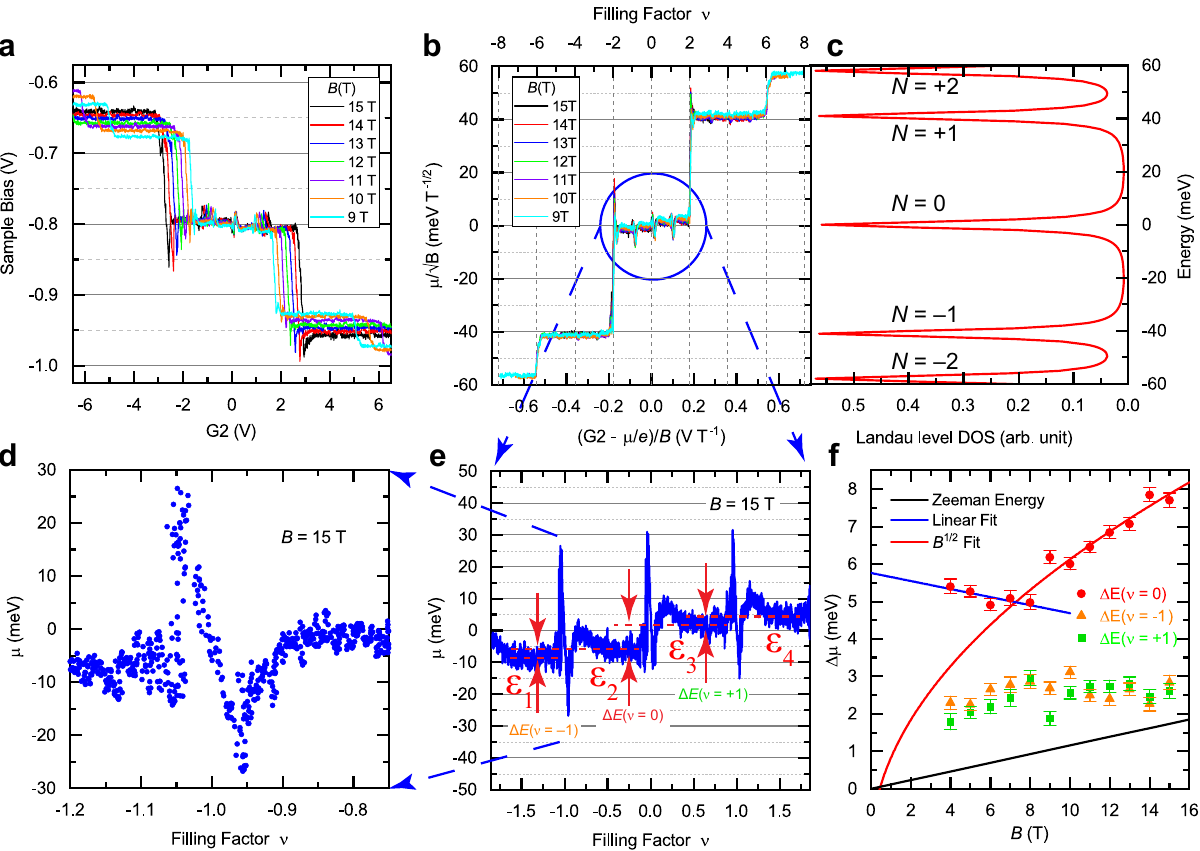
Fig. 3 Resolving the energies of the four isospin components of the graphene zero Landau level with Kelvin probe spectroscopy. a Kelvin probe measurements varying the sample bias and simultaneously gates G1 and G2 for measurements made outside the Hall bar area. A staircase of plateaus shows various Landau levels occurring at different chemical potentials for various magnetic fi elds. b Chemical potential vs. fi lling factor given by the data in p ( a ) collapsed onto a universal curve by scaling the sample bias by the graphene Landau level energy fi eld dependence along the vertical axis, E N / B , and by the B (cid:2) 1 along the horizontal axis to give a density/ fi lling factor axis. Each Landau level is observed by a plateau in the scaled chemical potential. Notice the zero Landau level at zero chemical potential consists of four separate small plateaus indicating the lifting of the fourfold degeneracy. c The Landau level density of states calculated using the expression in the main text with B ¼ 1T and v F ¼ 1 : 13 ´ 10 6 m = s to fi t the locations of the plateaus in ( b ). d Blow-up of the large up and down excursion in chemical potential at ν ¼ (cid:2) 1 and B ¼ 15T from ( e ). e Blow-up of the chemical potential of the zeroth Landau level at B ¼ 15T from ( b ) showing four individual chemical potential plateaus, labeled ε i , separated by large up/down excursions at the incompressible fi lling factors, ν ¼ 0 ; ± 1. The red dashed lines indicate the differences in chemical potential 4 E ¼ ð ε 2 (cid:2) ε 1 Þ ; ð ε 3 (cid:2) ε 2 Þ ; and ð ε 4 (cid:2) ε 3 Þ . f Energy differences extracted from the chemical potential plateaus in ( e ) for the ν ¼ 0 ; ð ε 3 (cid:2) ε 2 Þ (red circles) and ν ¼ (cid:2) 1 ; ð ε 2 (cid:2) ε 1 Þ and ν ¼ þ 1 ; ð ε 4 (cid:2) ε 3 Þ (orange triangles and green squares) fi lling factors. The values are averaged chemical potential difference values from ν (cid:2) 0 : 75 to ν (cid:2) 0 : 25 of each integer ν , and the error bars ffiffiffi p correspond to one standard deviation. The solid black line shows the Zeeman energy, g μ B , with g ¼ 2. The solid red line is a fi t for ν ¼ 0 data values to B B for values (cid:3) 8T, and the blue line is a linear fi t for B values (cid:4) 8T. AFM settings: 5.8 nm oscillation amplitude, 4 f ¼ (cid:2) 450mHz, 5 Hz bias modulation, except a 1 Hz bias modulation was used for 4 T and 5 T